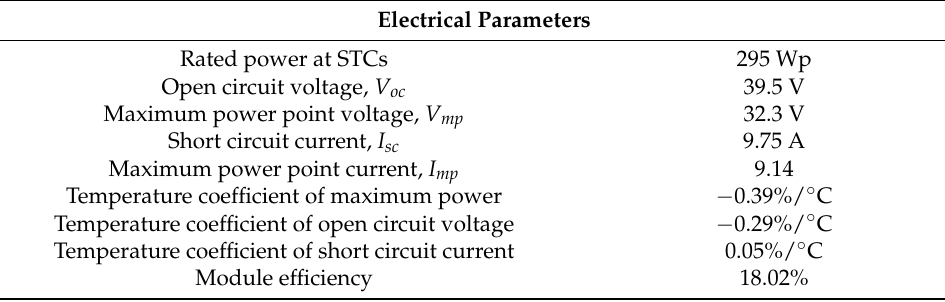
Table 1. Electrical parameters of the PV module [38].